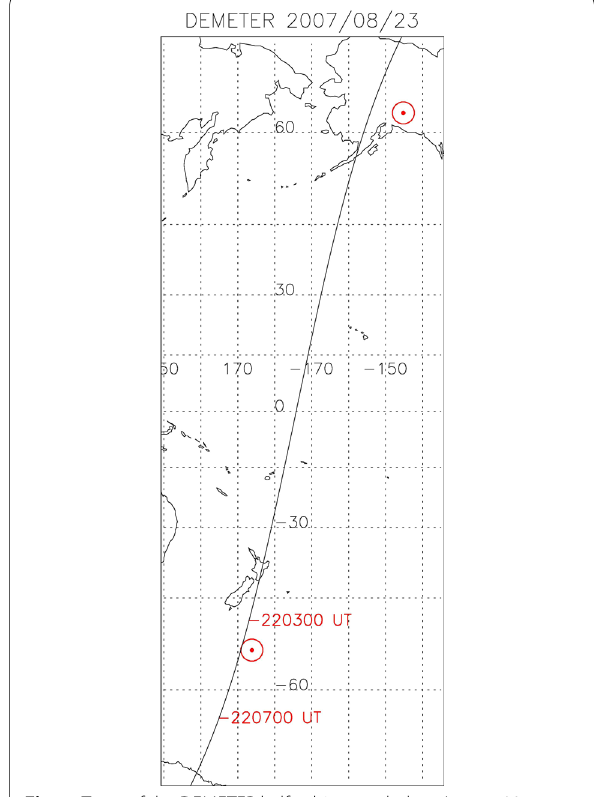
Fig. 1 Trace of the DEMETER half-orbit recorded on August 23, 2007 with times. The positions of HAARP and its conjugate point are indicated by red dots and circles. The advantage of a day time half-orbit is that if the track is close to HAARP in the Northern hemisphere, it is also close to the HAARP conjugate point a few tens of minutes after in the Southern